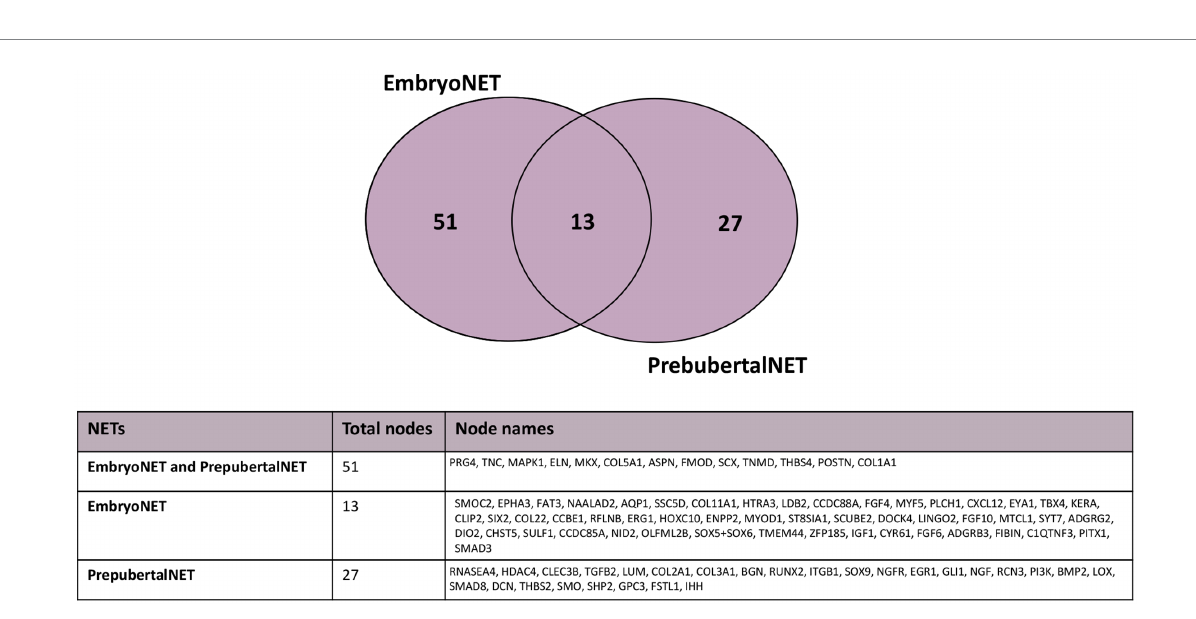
FIGURE 5 Venn diagram representing the shared nodes of the embryo TendonNET and the prepubertal TendonNET of m model organism. The classification of nodes in the embryo or prepubertal category was defined during the data collection (Supplementary File